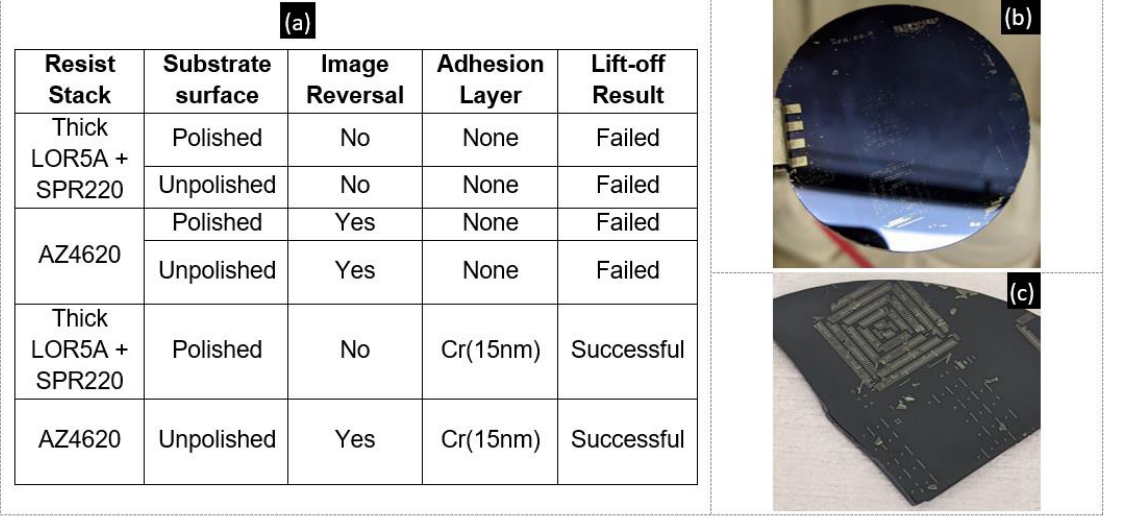
Figure 7. ( a ) Increase in the Seebeck coefficient of n-type Se12xTe1x thin films seen upon long bakes at higher temperatures of 320 °C (Sample 1 – > S1) and 360 °C (Sample 2 – > S2). ( b ) Seebeck coefficients of the optimum thin films obtained from pellet composition of Se9xTe2x, and a high-temperature bake at 360 °C. Short-term high heat treatment at 500 °C showed improvement but was also seen to damage the surface of one of the samples; hence, it was excluded from the subsequent batches.